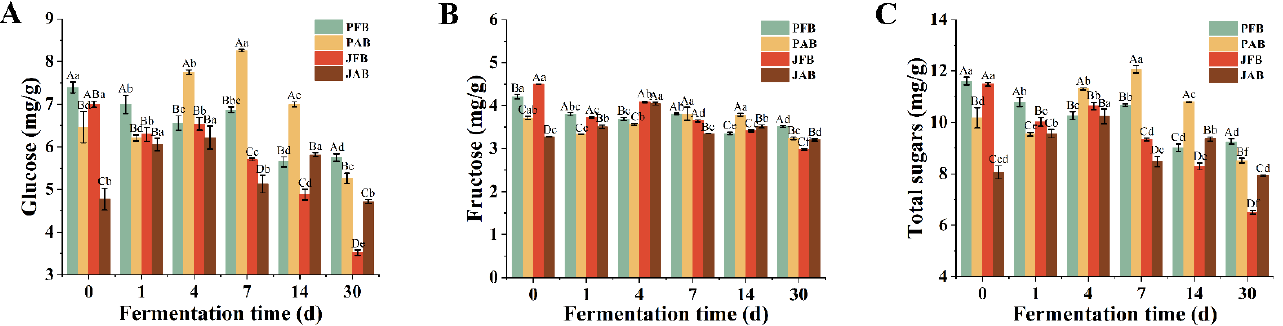
Figure 2. Glucose ( A ), fructose ( B ), and total sugars ( C ) of pickled chili pepper processed by PFB, PAB, JFB, and JAB ( n = 3). Different capital letters (A – D) indicate significant differences in different treatments ( p < 0.05); different lowercase letters (a – f) indicate significant differences as a function of fermentation time ( p < 0.05).